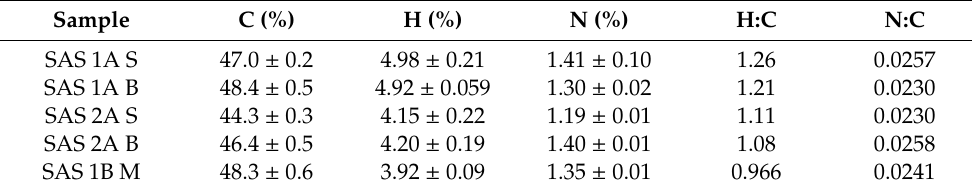
Table 4. Average elemental composition and atomic ratios of PPL-DOM SAS samples. Sample C (%) H (%) N (%) H:C